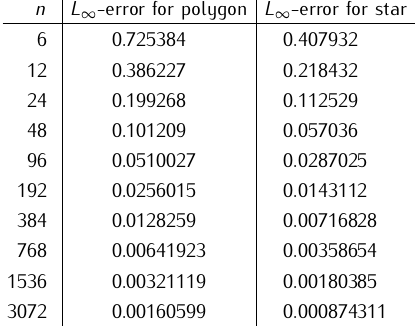
∞ -errors for ‘ = 1 and ‘ = n n L ∞ -error for polygon L ∞ -error for